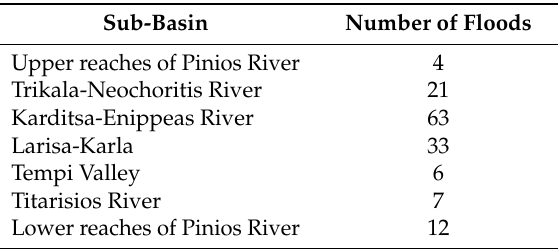
Table 2. Spatial distribution of flood occurrences in each drainage sub-basin of the study area during the period